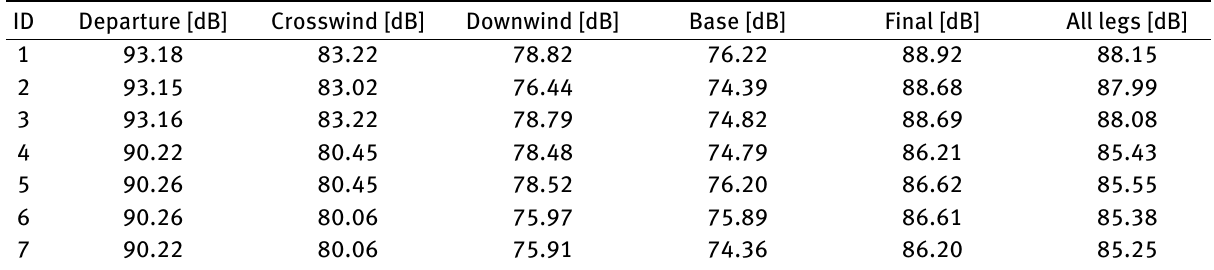
Table 7: Average SEL for the Cessna T206H Stationair. Results for conditional activation cases listed in Table 6.